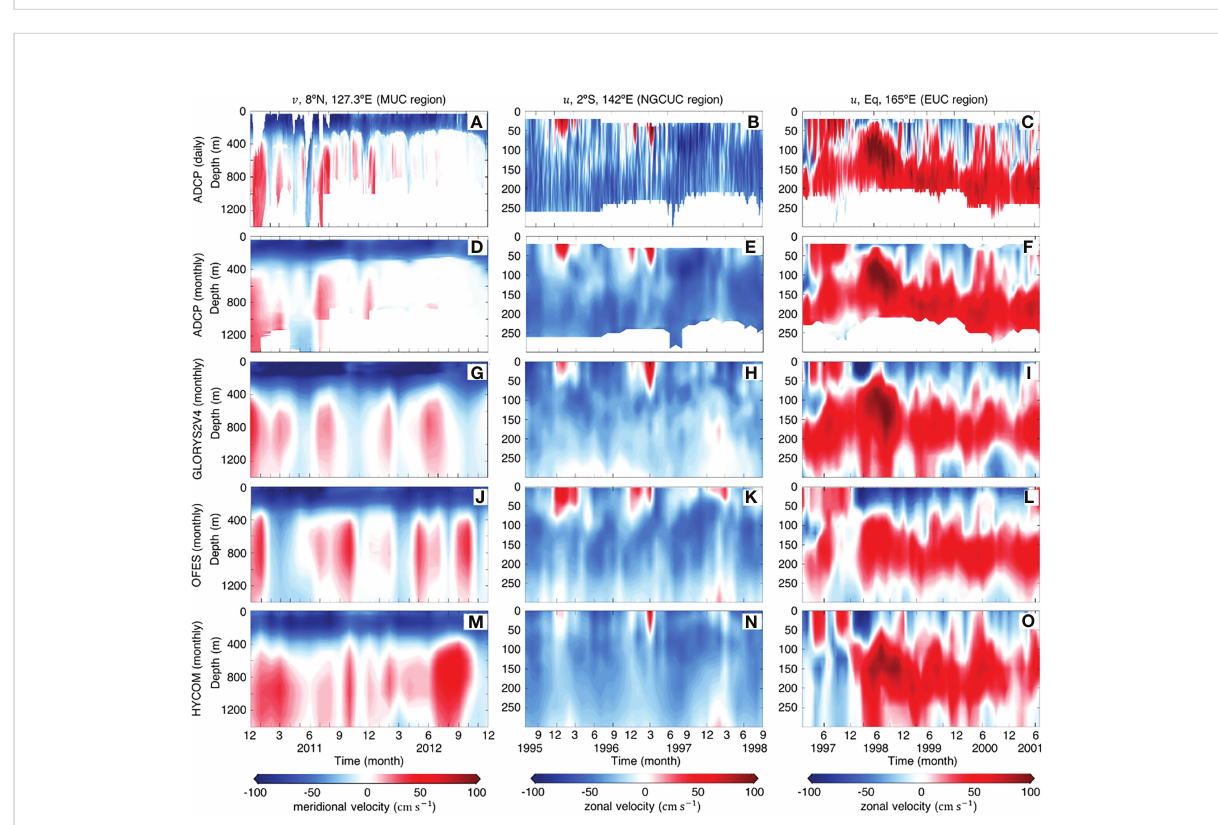
FIGURE 3 Time-depth sections of velocities (cm s -1 ) from [ fi rst-row panels (A-C) ] daily ADCPs, [second-row panels (D-F) ] monthly ADCPs, [third-row panels (G-I) ] monthly GLORYS2V4, [fourth-row panels (J-L) ] monthly OFES, and [ fi fth-row panels (M-O) ] monthly HYCOM at approximately (left panels) 8°N, 127.3°E, (middle panels) 2°S, 142°E, and (right panels) Equator, 165°E. The left, middle, and right panels are meridional, zonal, and zonal velocities,